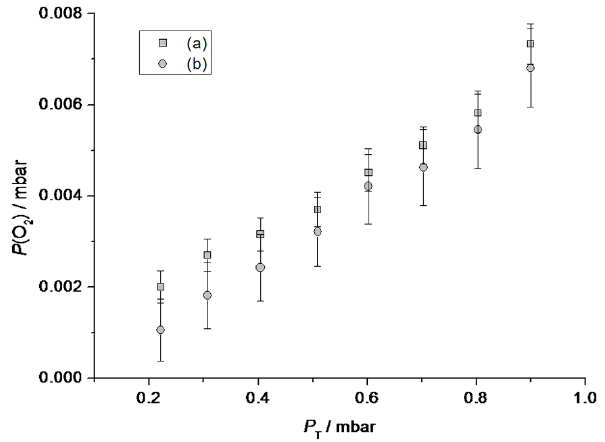
Figure 4. Oxygen pressure in the residual gas evaluated by pressure difference (a) and with the calibrated RGA (b) .